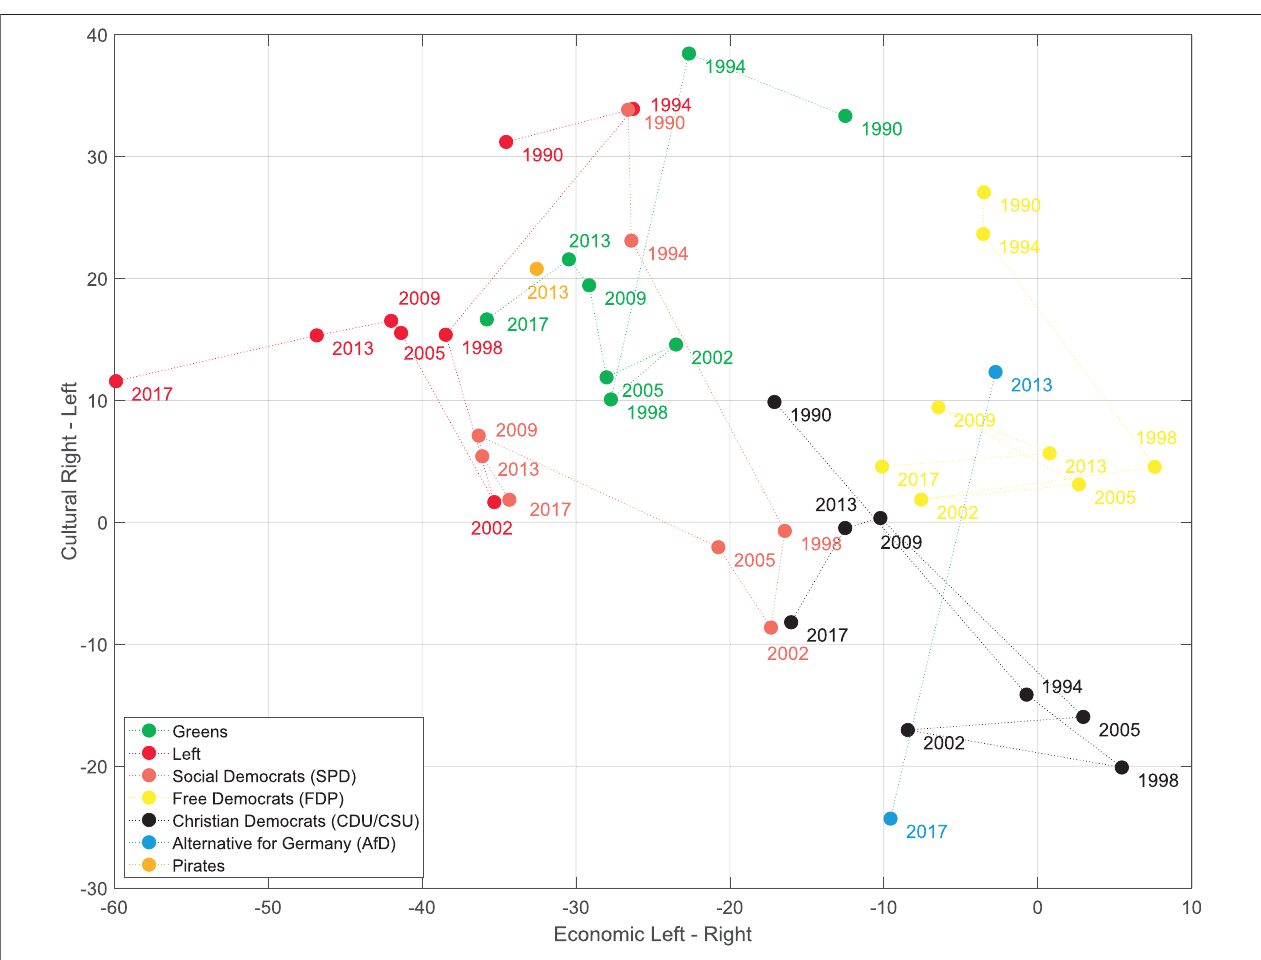
FIGURE2| Projectiononthe2-dayspoliticalspacewiththeeconomicandculturalaxisspannedbythedifferencebetweentheeconomicandculturalleftandright categories, respectively (see Table 5 ) of the German parties between 1998 and 2017.